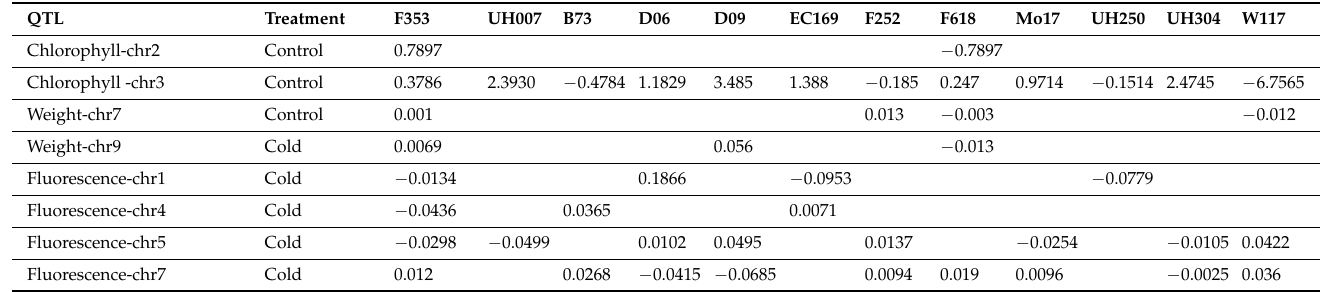
Table 3. Additive effects of QTL alleles carried by each parental inbred line for chlorophyll content (Chlorophyll) dry weight (Weight) and F v /F m (Fluorescence) under control and cold